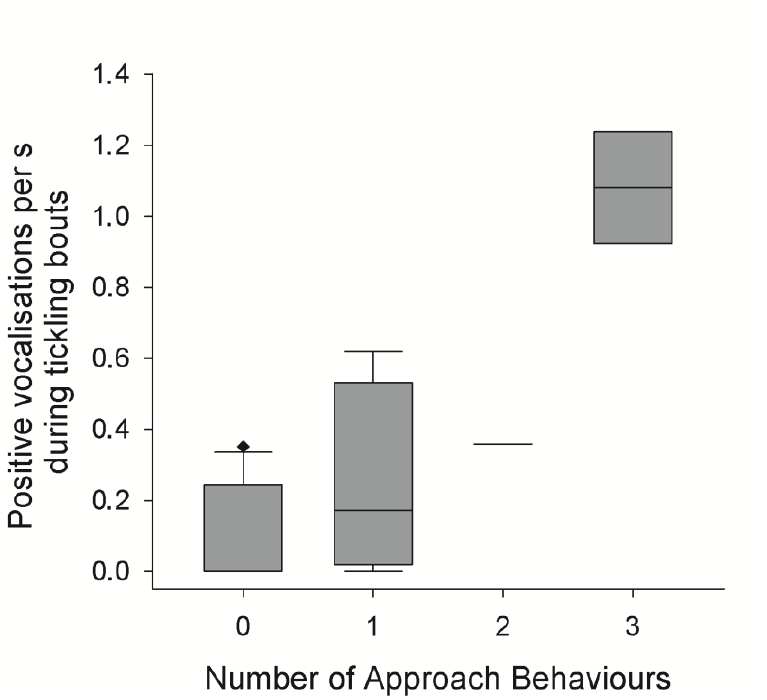
Figure 3 . Association between positive vocalizations during tickling and approach behavior after tickling bouts in the Tickling